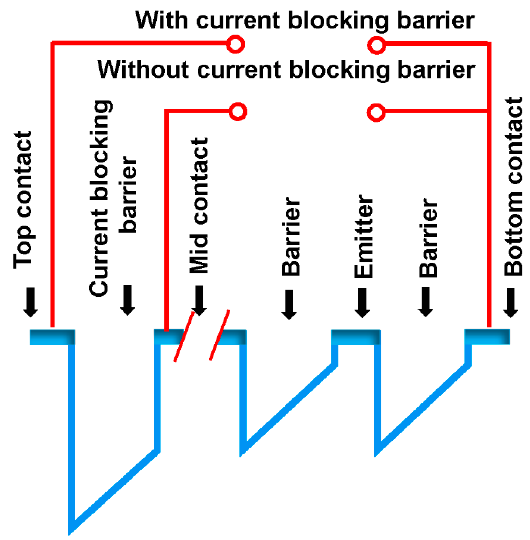
Figure 4. Schematic of the valence band alignment of the heterostructure under equilibrium showing the connections with and without the current blocking the connections with and without the current blocking barrier.